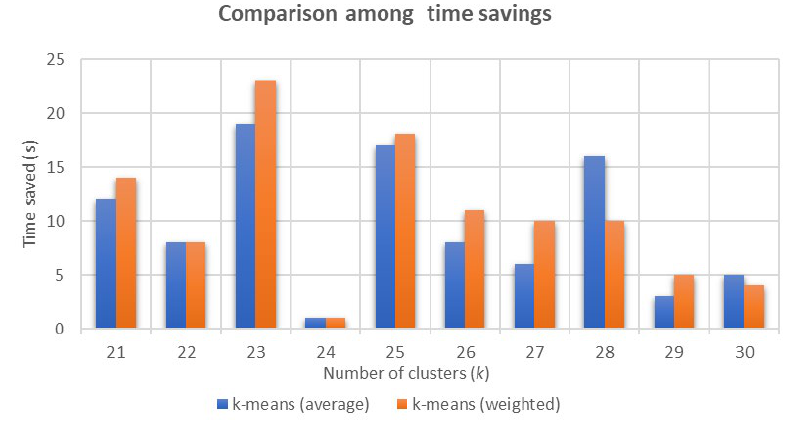
Figure 6. Evolution of time saved with respect to having one cluster less for different numbers of clusters.